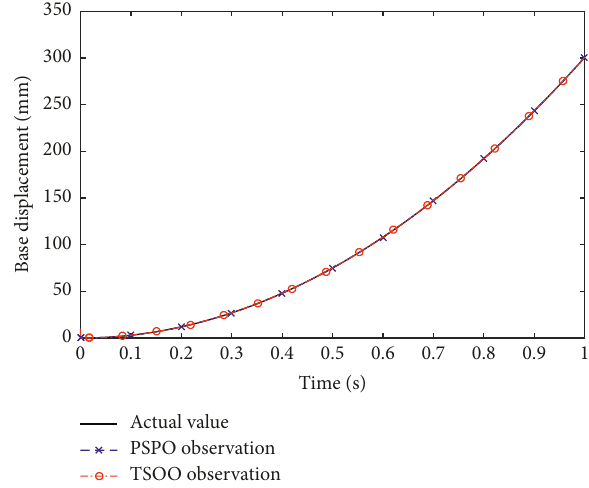
Figure 3: Observation effects of the TSOO and the PSPO on the base